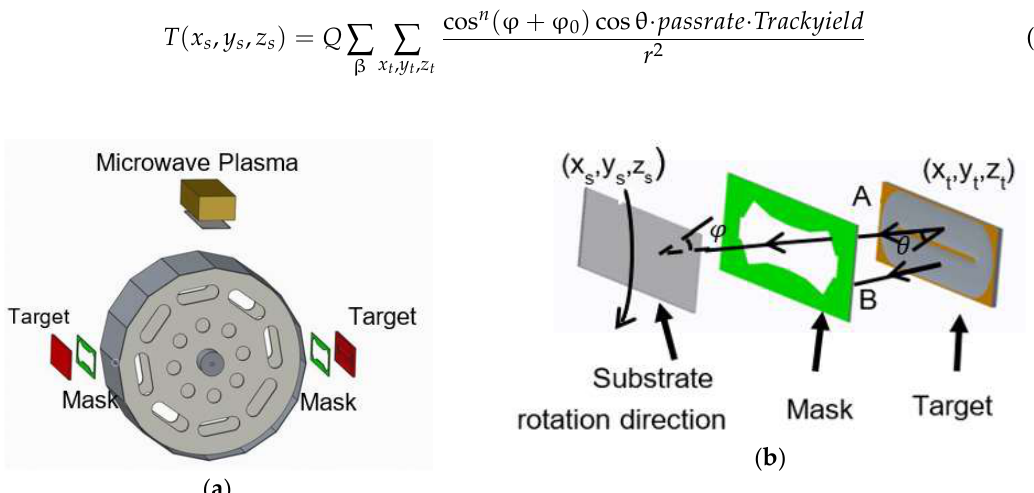
Figure 28. ( a ) Rotating drum substrate holder. ( b ) θ is the emission angle to the target surface of ejected sputter flux; φ is the incident angle to the substrate surface of deposited atom flux; path A: direct line of sight from target to substrate; path B: mask blocked sputter